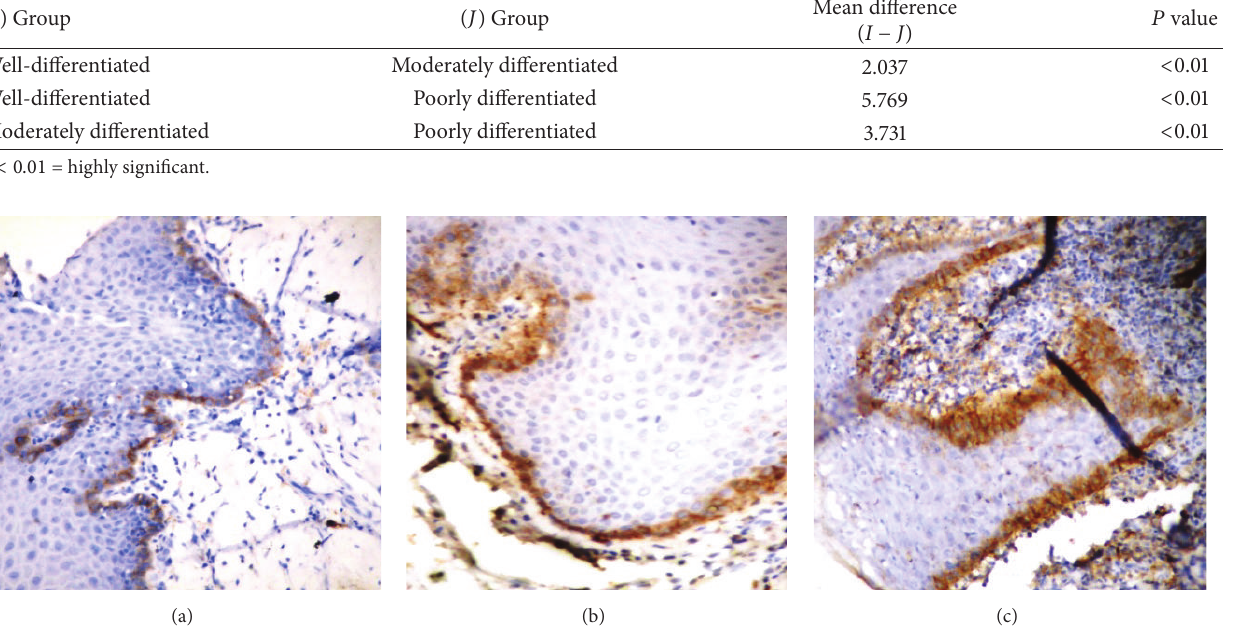
Figure 3: (a) Expression of podoplanin in oral leukoplakia: Score 1—expression restricted to basal layer of epithelium. (b) Expression of podoplanin in oral leukoplakia: Score 2—expression observed in basal and suprabasal layers at one area. (c) Expression of podoplanin in oral leukoplakia: Score 3—expression observed at two suprabasal areas.